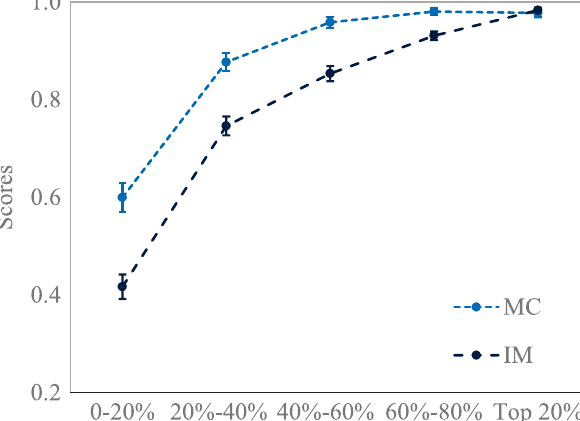
FIG. 8. Scores on momentum conservation and impulse- momentum theorem of Chinese students in different performance groups. The five performance groups are determined by students ’ physics exam scores. The error bars represent standard